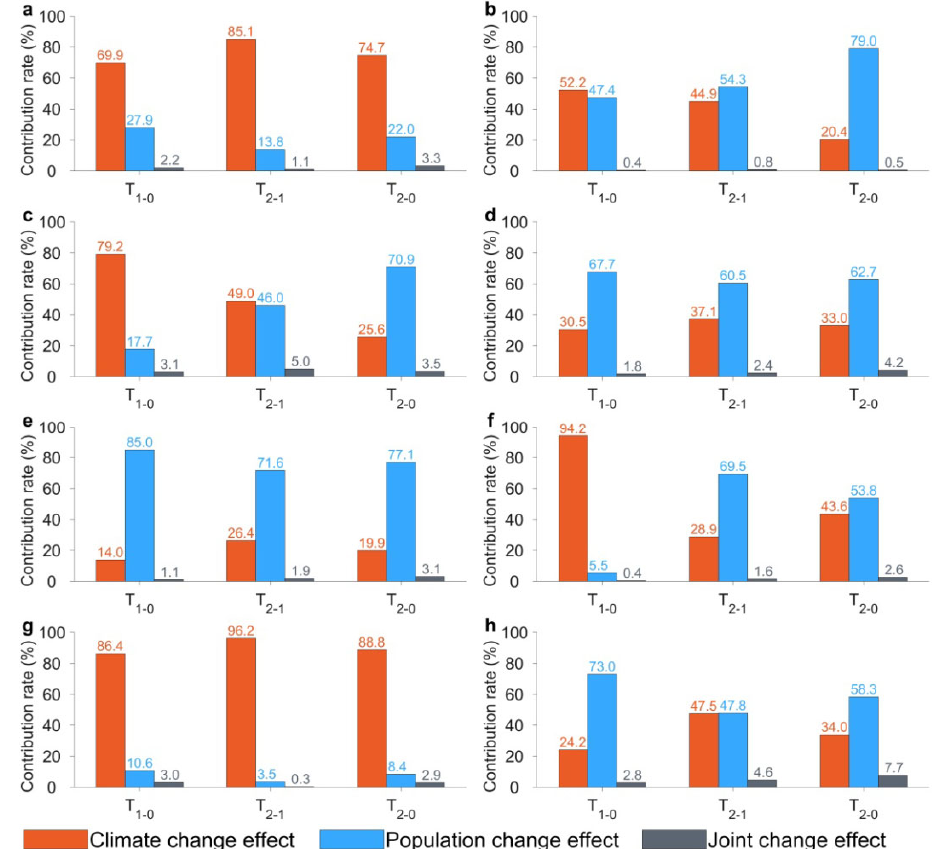
Figure 7. Breakdown of the changes in population exposure for tropical cyclone hazard scenario I in the Northwest Pacific. ( a ‐ h ): Breakdown of the change in population exposure for regions A, B, C, D, E, F, G, and H, respectively.